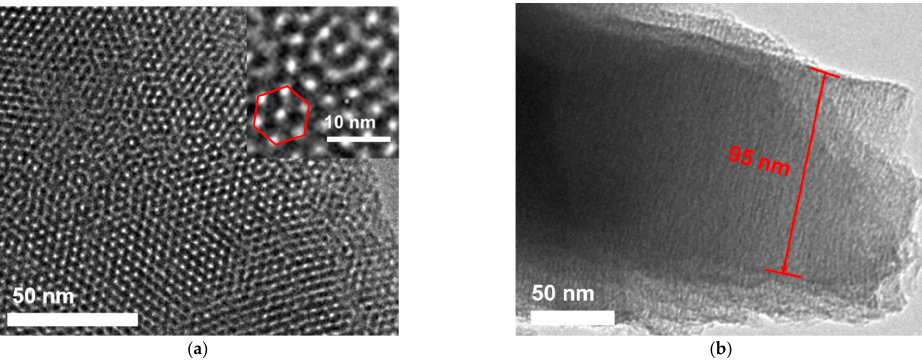
Figure 4. Top-view ( a ) or cross-sectional ( b ) TEM photos of VMSF. Inset in ( a ) is the high-resolution TEM (HRTEM) image. TEM (HRTEM)